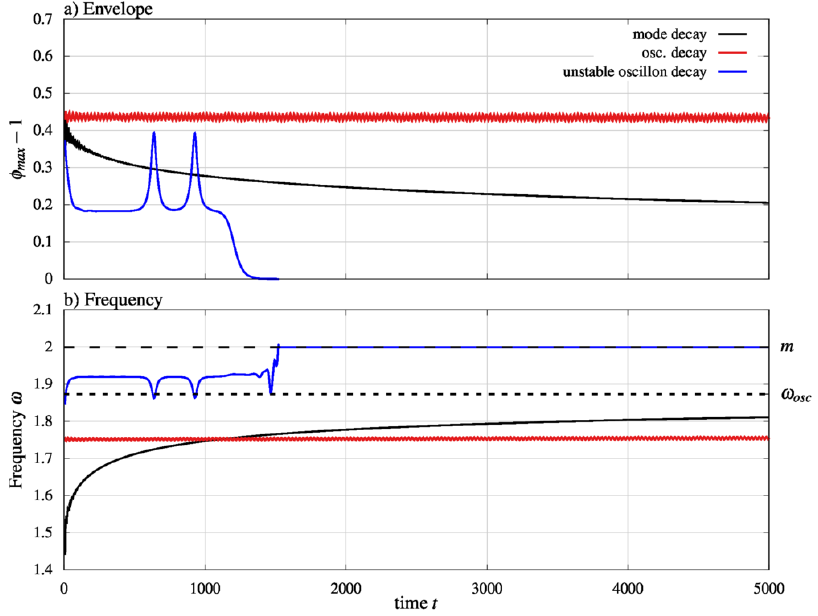
Figure 6 . Possible relaxation scenarios for A 0 = 0 : 6. The plots show the maximum envelope of oscillations at x = 0 (upper plot) and the measured frequency as ! = 2 (cid:25)=T (bottom plot), where T is time between the subsequent maxima. Decay of the oscillational mode (black curve); usual evolution of the oscillon con(cid:12)guration (red curve); decay of the unstable oscillon in the repulsive potential (blue